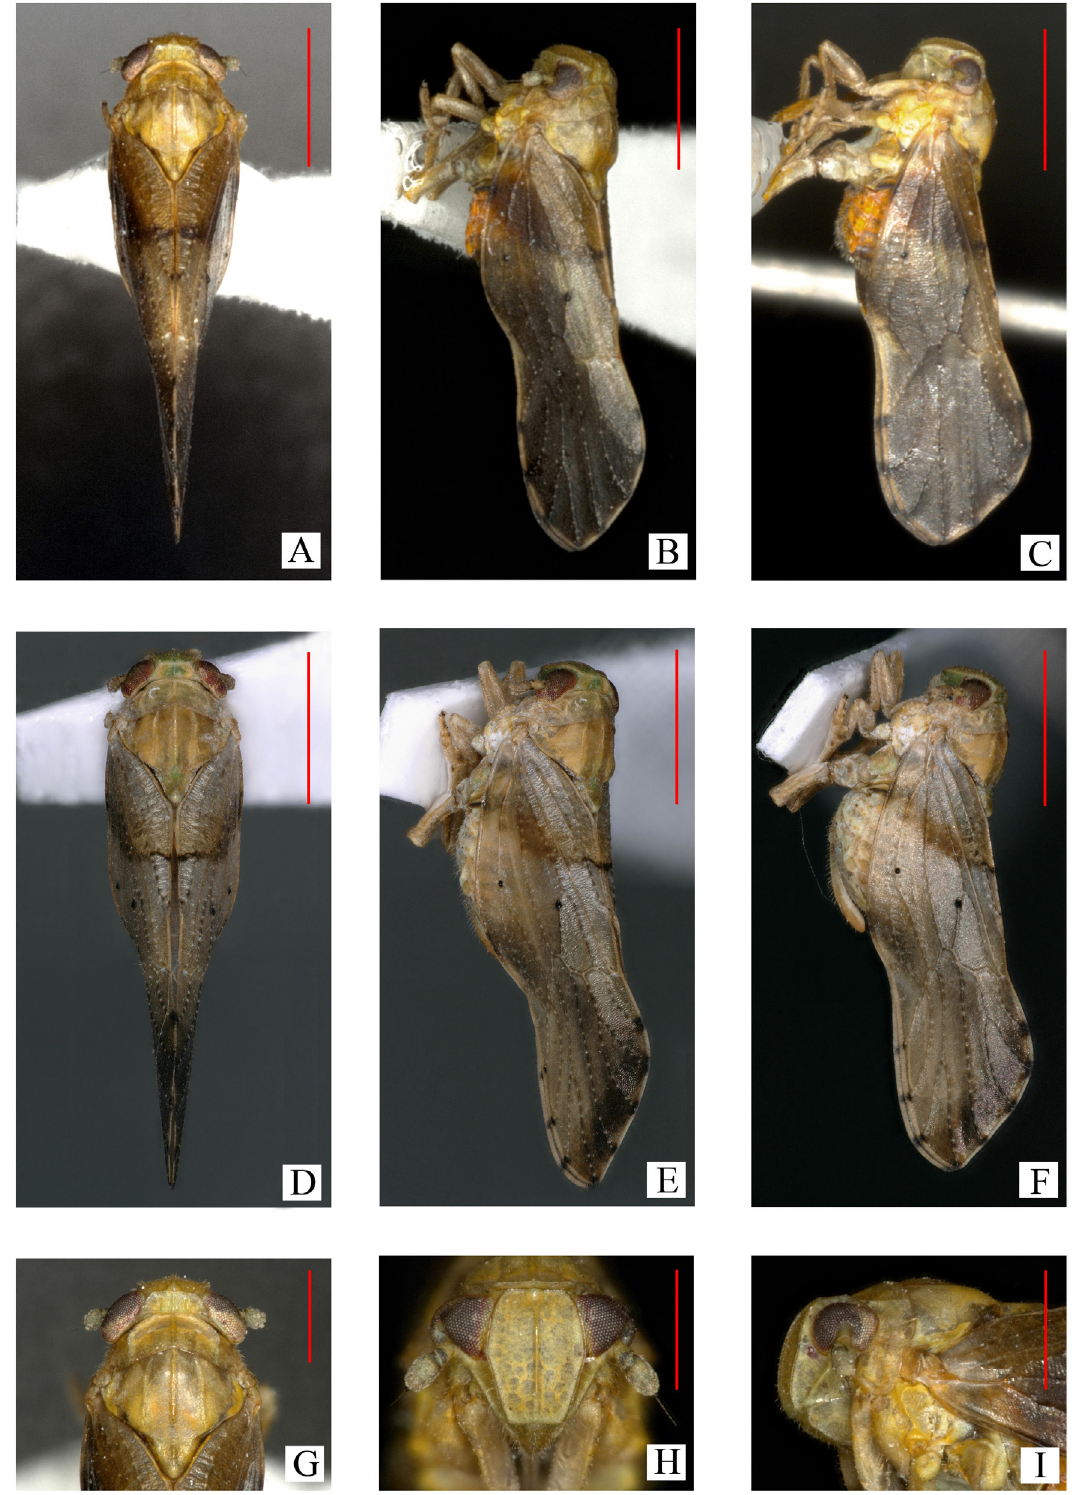
Fig. 3. Arcofaciella obflexa Guo & Liang, 2005. A–C, G–I = ♂ (GUGC-FDTA-20190601); D–F = ♀ (GUGC-FDTA-20190602). A . Male habitus, dorsal view. B–C . Same, lateral view. D . Female habitus, dorsal view. E–F . Same, lateral view. G . Head and thorax, dorsal view. H . Face. I . Frons, lateral view. Scale bars: A–F = 1 mm; G–I = 0.5